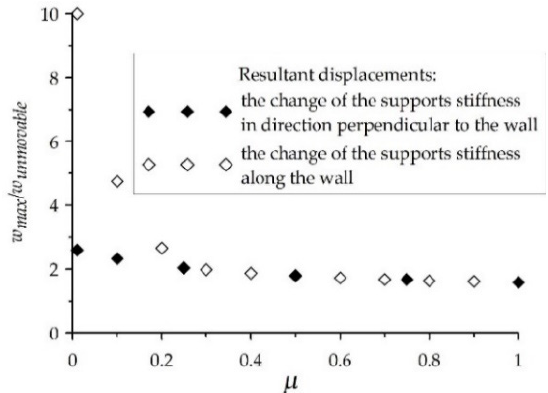
Figure 7. Maximum resultant displacements depending on µ value.